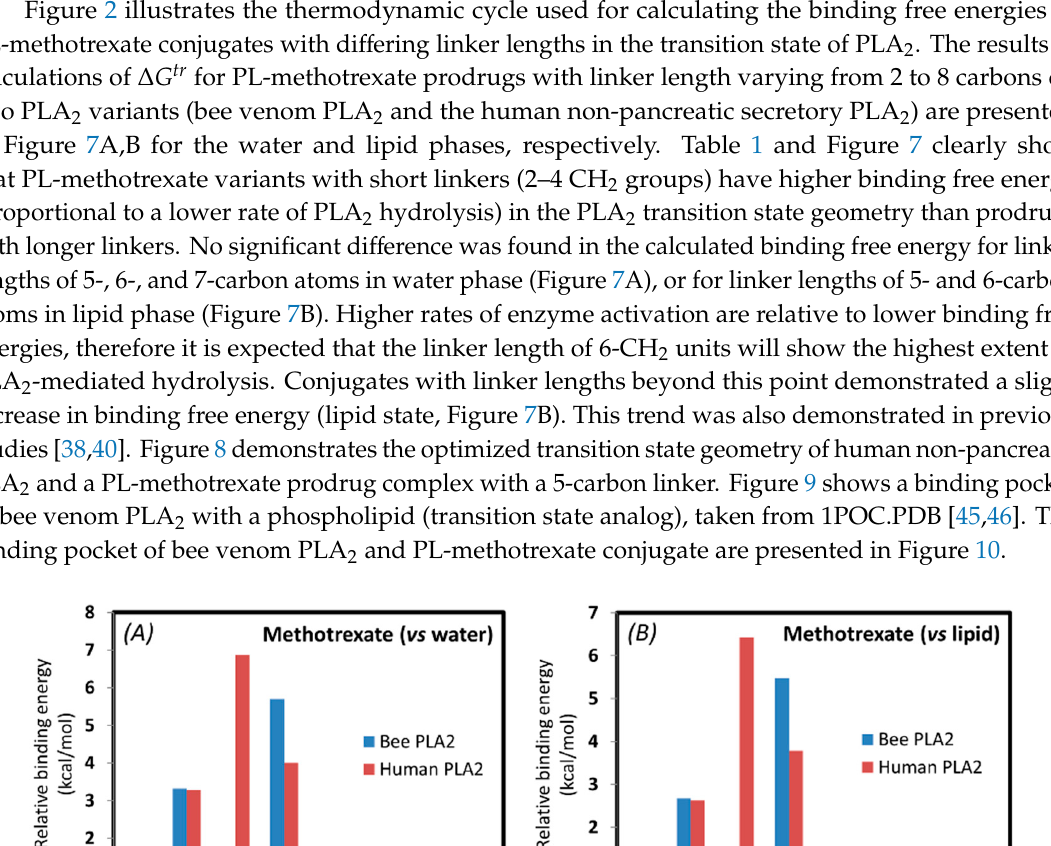
Table 1. Binding free energies of PL-methotrexate prodrugs in bee venom vs. human PLA 2 transition state from water or lipid (kcal/mol), as calculated by the thermodynamic cycle illustrated in Figure 2. All simulations had standard error of the mean (SE) in the range of 0.5–1.0 kcal/mol.